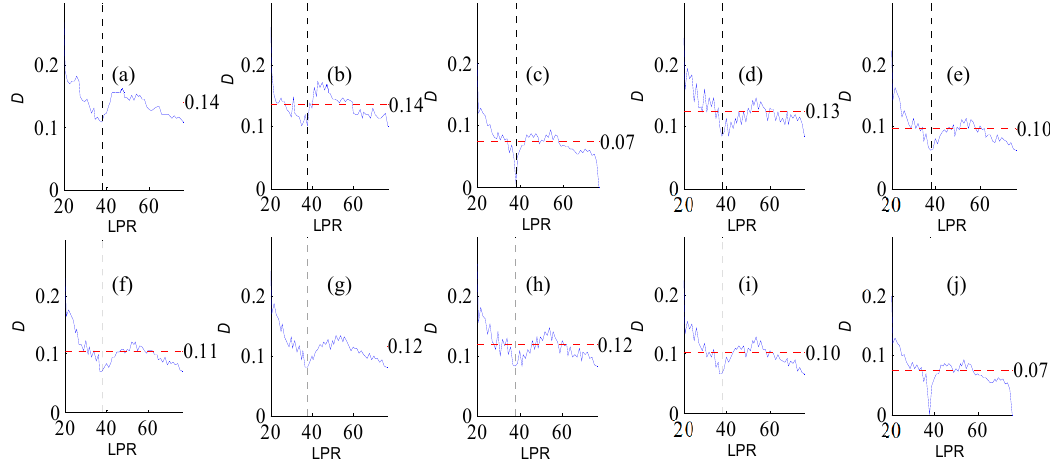
Figure A28. Variation of flow regime alteration degree (D) measured by the RVA with change in the length of post-impact flow time series (LPR) under a periodicity of 38 years. ( a – j ) correspond to pre-impact flow time series length = 27, 33, 38, 43, 49, 54, 60, 65, 71, and 76 years, respectively. The abscissa value for the vertical dotted line is 39. The ordinate value for the horizontal dotted line is the mean degree of flow regime alteration in each subfigure.